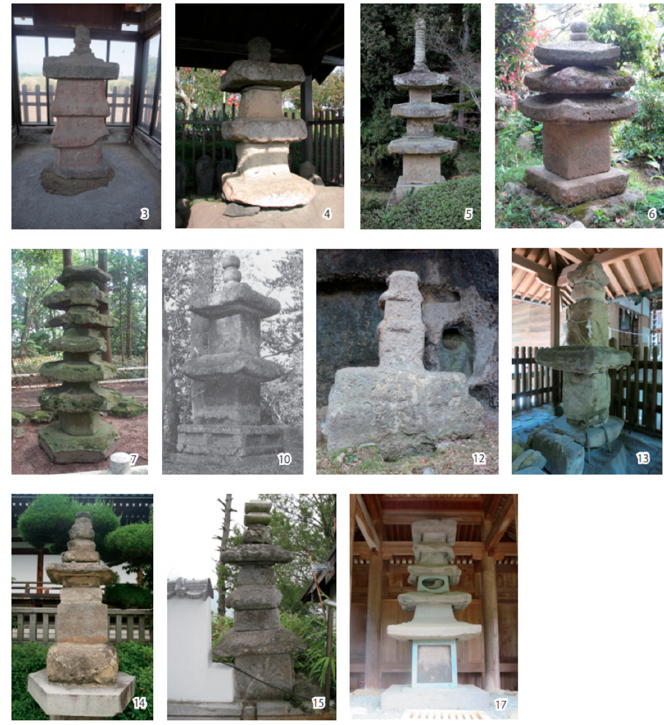
Religions 2021 , 12 , x FOR PEER REVIEW Figure 4. Stone pagodas in ancient Japan. Figure 4. Stone pagodas in ancient Japan.